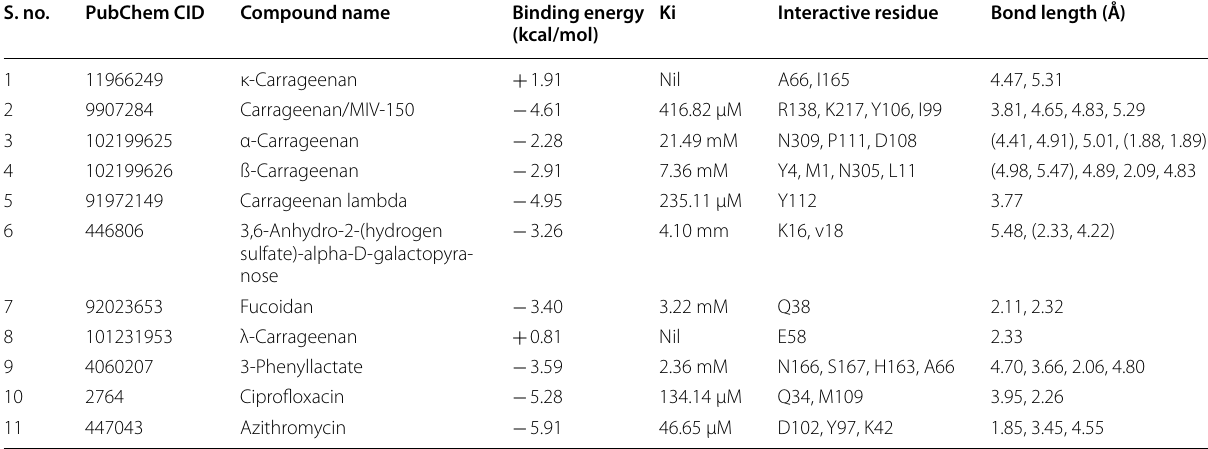
Table 1 Binding energy, inhibition concentration (Ki), interactive residue, and bond length of the SSP and commercial typhoid drugs docked against S. typhi